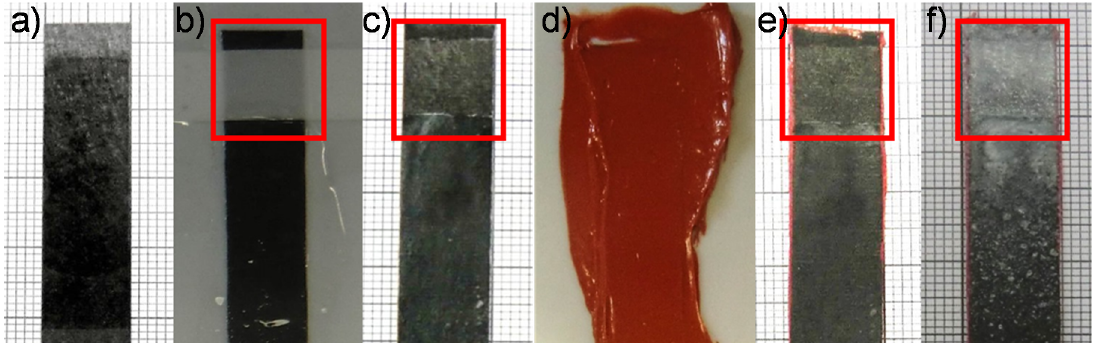
Figure 3. Manufacturing of the sensor ( a ) activated material, ( b ) coating with glue, ( c ) limited active area, ( d ) silicone coated back, ( e ) bare sensor, ( f ) active area with ceramic layer.